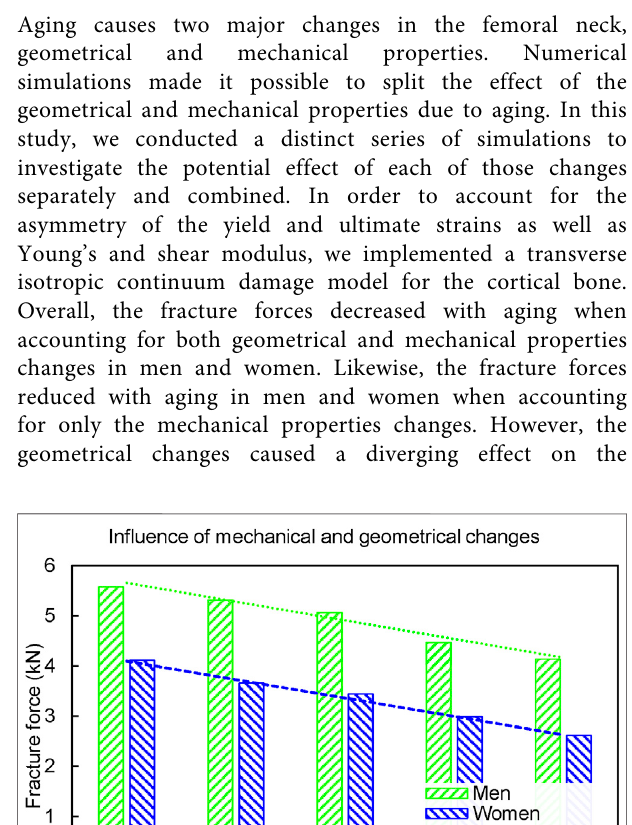
Frontiers in Mechanical Engineering |